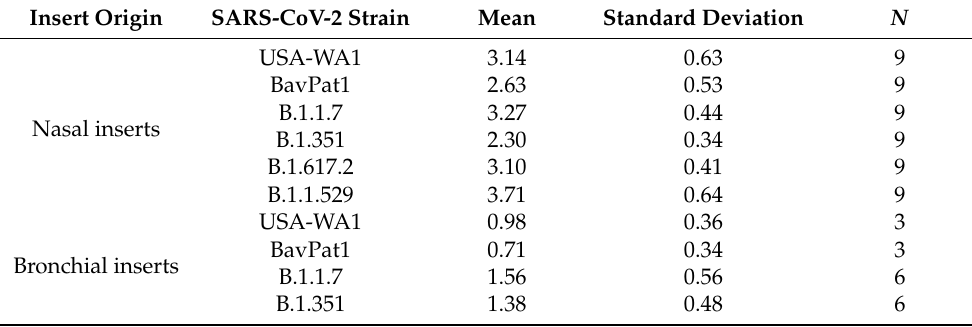
Figure 7. Comparison of SARS-CoV-2 virion infectivity in different human respiratory tissues. For this analysis, infected samples on day 2 p.i. from independent experiments were pooled. The relative infectivity is expressed as log 10 inverse ratio of TCID 50 -per-copy. A comparison between the different cell types ( A ) as well as a comparison between the different VoCs ( B ) is shown. Each dot represents individual cultures and statistical significance was determined by two-way ANOVA with a Turkey post-hoc test. * p < 0.05, ** p < 0.01, *** p < 0.001, **** p < 0.0001. Table 1. Descriptive summary of log 10 inverse ratio of TCID 50 -per-vRNA